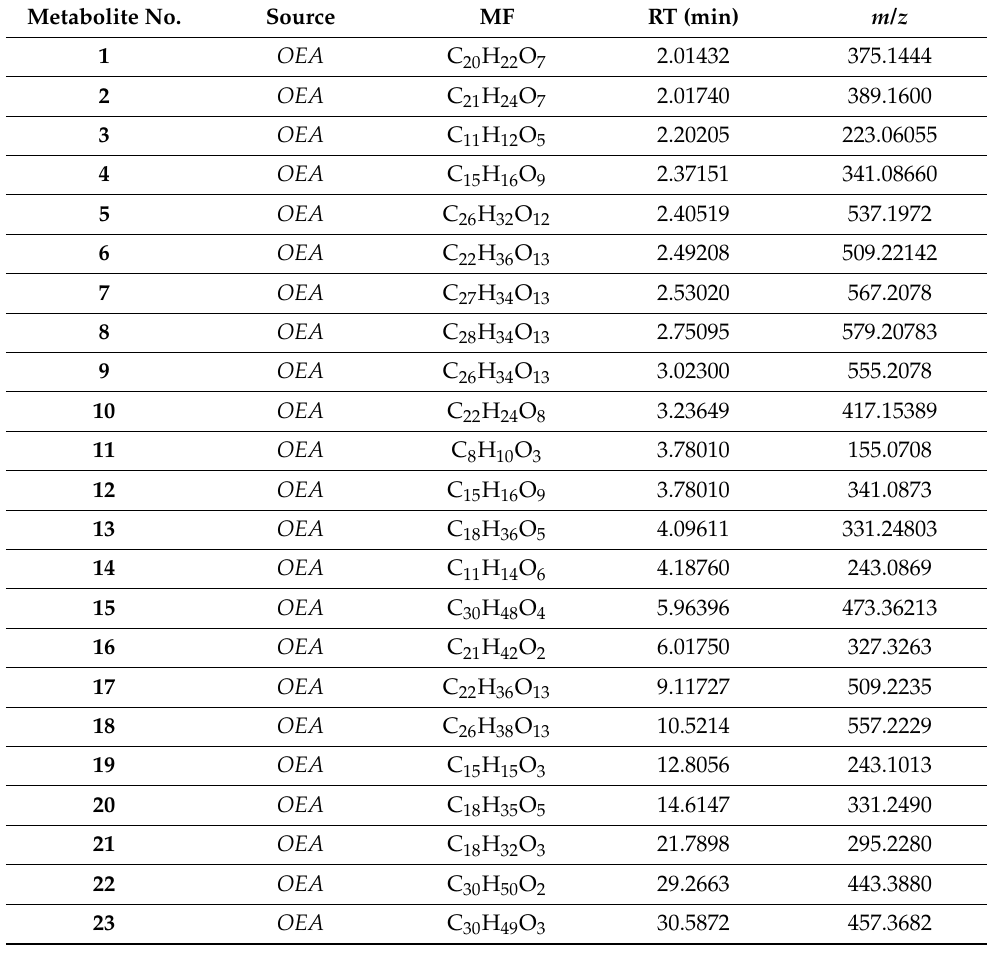
Table 2. Dereplicated metabolites from LC-HRESIMS analysis of OEA leaves crude extract.